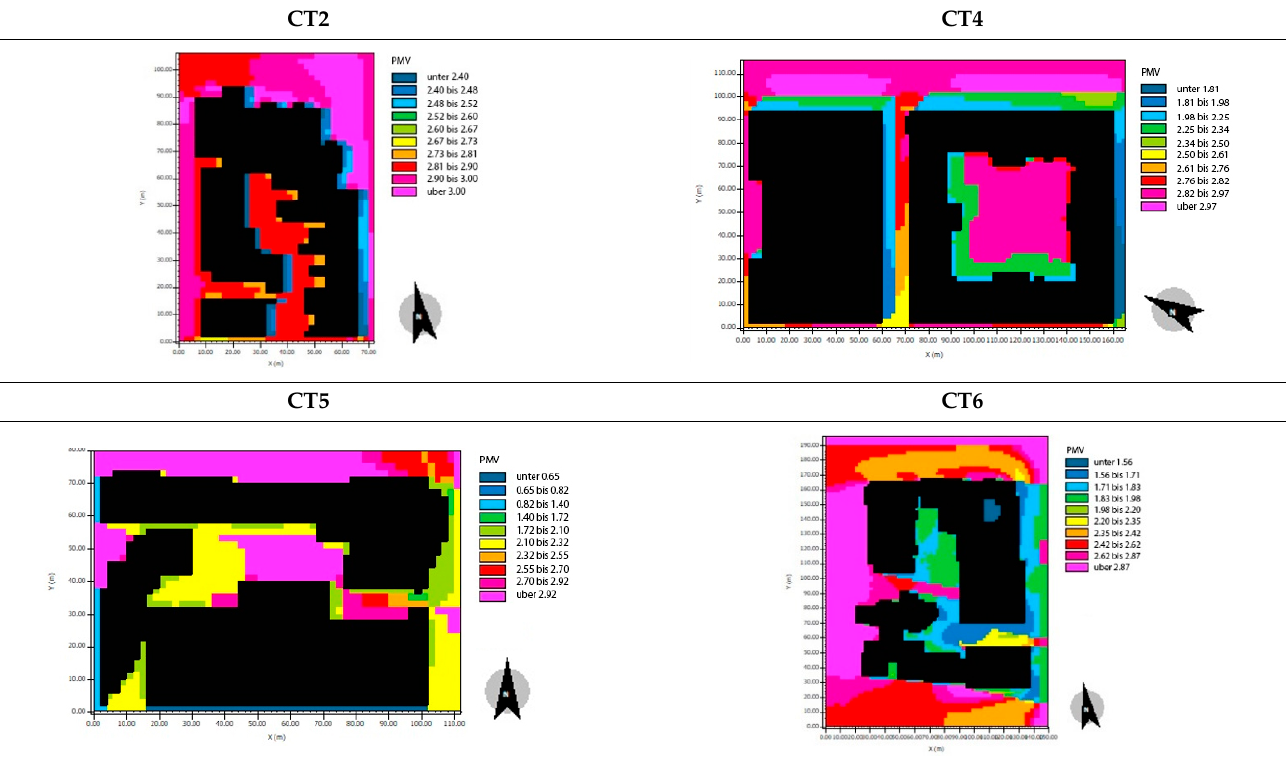
Table 10. Summary of the outdoor thermal comfort based on PMV in compact-type arrangement on 17th January.